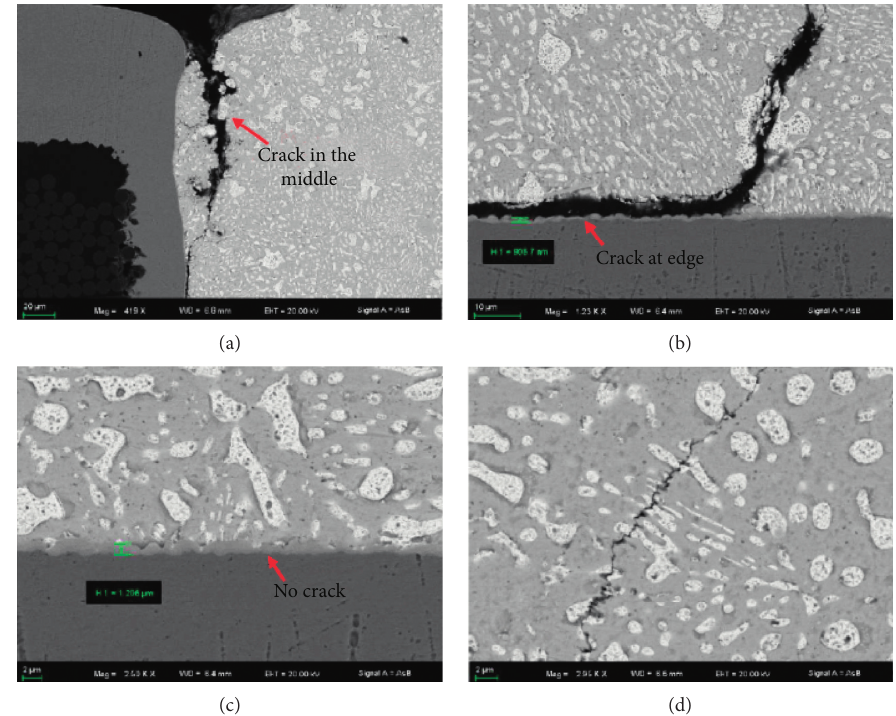
Figure 14: Partial view of the cracks on power control board terminal: (a) crack in the middle of the solder, (b) crack at the interface, (c) no crack at the interface, and (d) partial enlarged view of the solder crack.